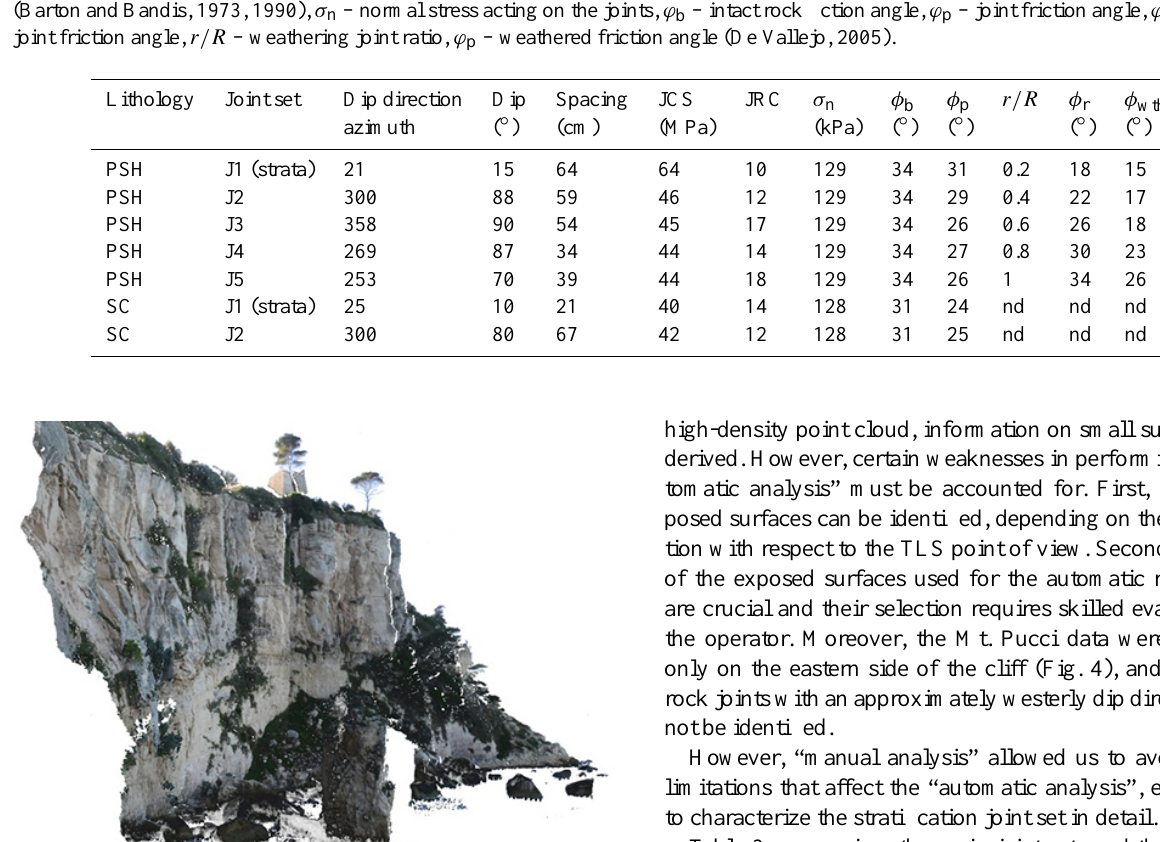
Table 4. Geomechanical properties attributed to the recognized joint sets: JRC – joint roughness coefficient, JCS – joint compressive strength (Barton and Bandis, 1973, 1990), σ n – normal stress acting on the joints, ϕ b – intact rock fiction angle, ϕ p – joint friction angle, ϕ p – residual